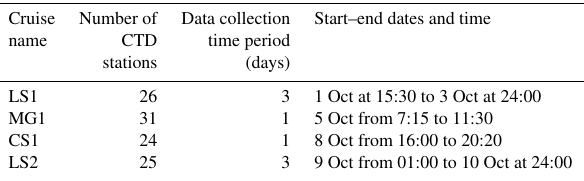
Table 1. number of CTD stations carried out during the surveys at large, shelf and harbor scales.